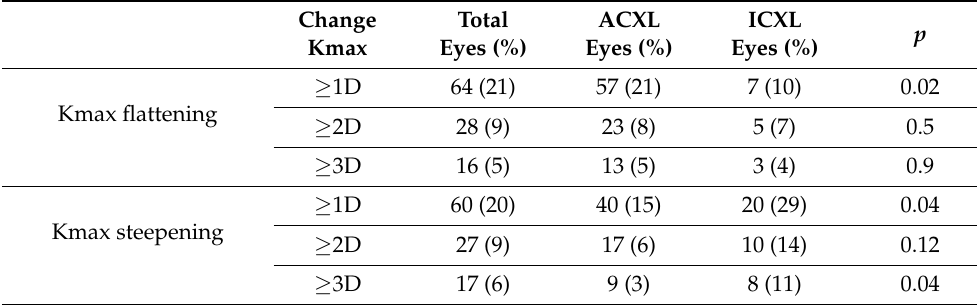
Table 3. Proportion of eyes with steepening or flattening of Kmax above 1 diopter at last visit for the entire cohort and for A-CXL and I-CXL groups showing a higher proportion of eyes with Kmax steepening above 3 diopters following I-CXL.